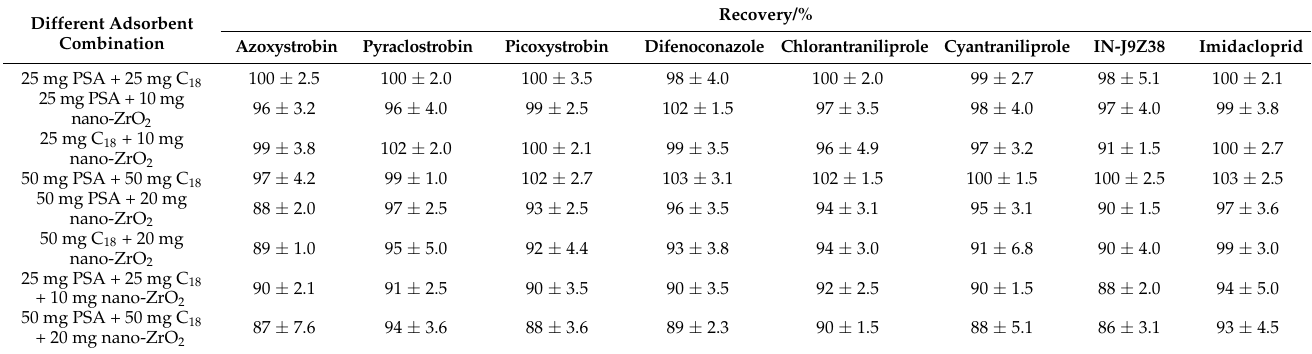
Table 2. Effect of adsorbent dosage on the recovery of eight targeted compounds in litchi and longan samples ( n = 5).